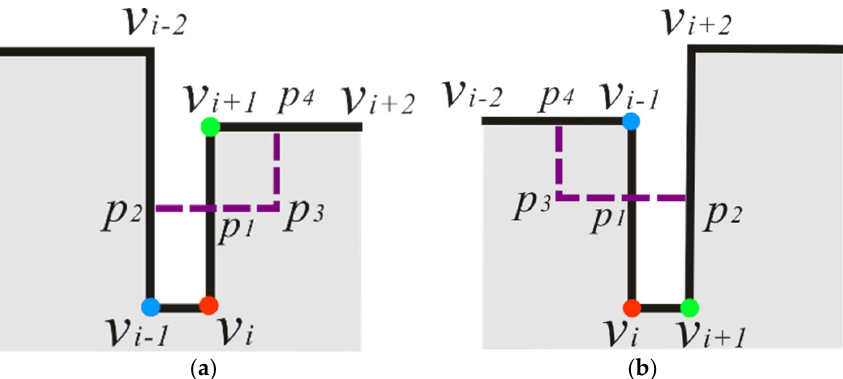
Figure 7. The Exaggeration types and their operations: ( a ) Exaggeration 1 , and ( b ) Exaggeration 2 .